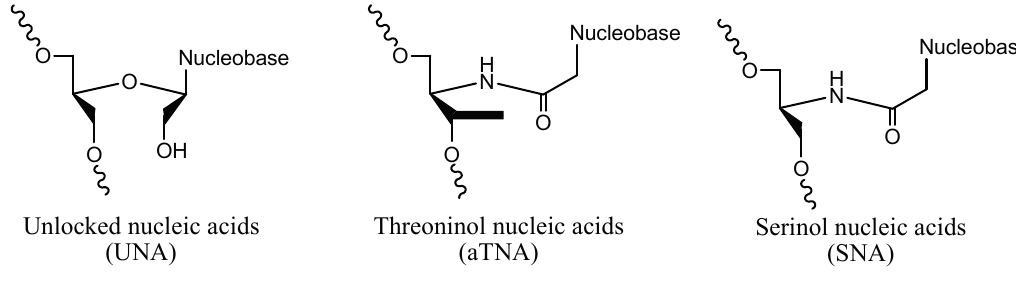
Figure 1. Chemical structures of flexible acyclic derivatives of nucleosides used in RNA interference experiments. Threoninol and serinol nucleic acids may be formed by D or L